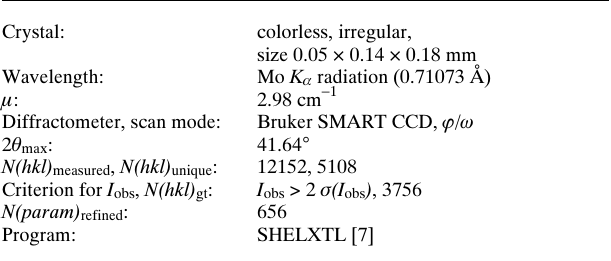
Table 1. Data collection and handling.